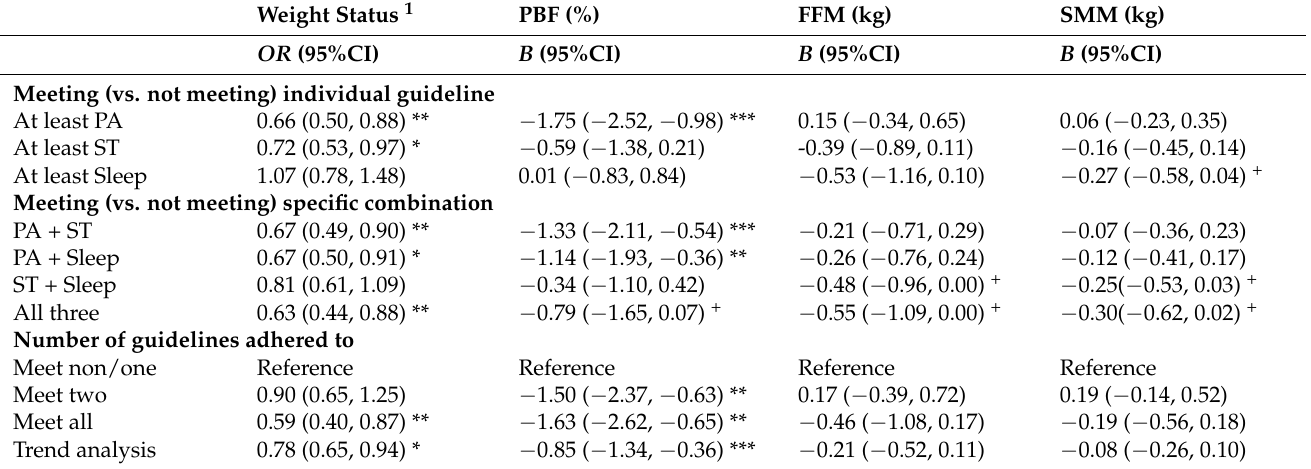
Table 4. Associations of meeting 24 h movement guidelines with weight status and body composition among the study